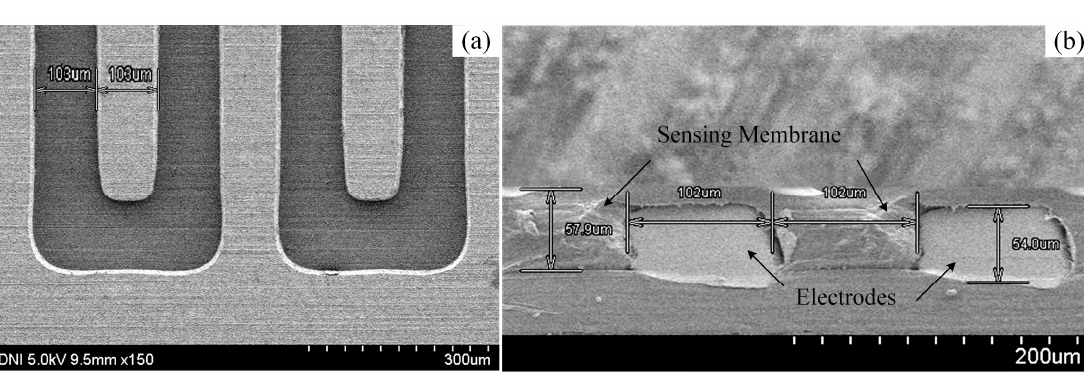
Figure 3. SEM images of the preparead IDE ( a ) Top view without sensing membrane; and ( b ) cross-sectional view of the IDE with sensing membrane.